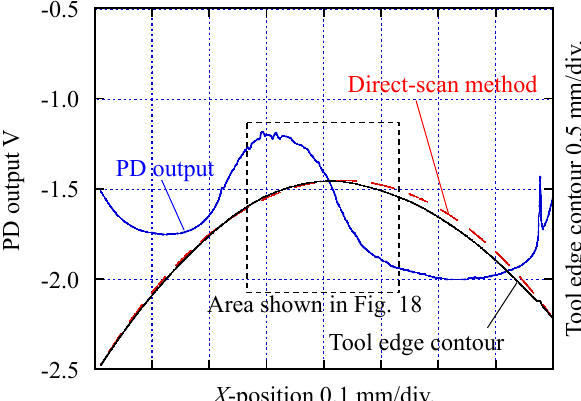
Figure 17. Deviation of the out-of-roundness measured by the direct-scan